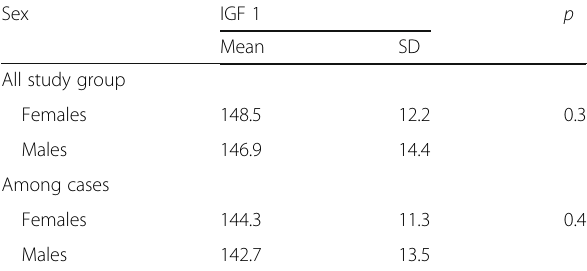
Table 2 comparison of IGF-1 between males and females among the study